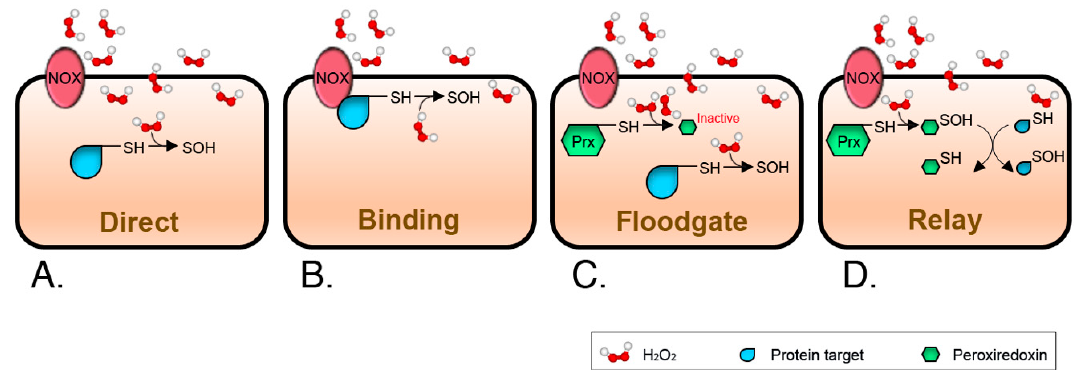
Figure 2. Main models for ROS signal transmission to specific cysteines. ( A ) The direct model presumes that redox targets (depicted as a blue teardrop) are constituted by proteins whose rate constant of oxidation is higher than that of the reaction of ROS with its major cellular scavengers, particularly peroxiredoxins. Direct chemical reaction of ROS with those targets is thus kinetically possible and leads to their oxidation. ( B ) The binding hypothesis proposes that H 2 O 2 sources and targets are bound or in close proximity, allowing for site-localized oxidation to occur. Also in this case, ROS will directly oxidize targets but as a function of their relative proximity to the source instead of depending on their rate constant of reaction. ( C ) The floodgate model overcomes the apparent kinetic limitation of target oxidation by suggesting that overoxidation of peroxiredoxins (represented by green hexagons) permits further oxidation of other proteins with slower reaction rates. ( D ) Peroxiredoxins have been already shown to behave as relays, transmitting redox equivalents to targets during their oxidation–reduction cycle, and thus allowing for signal transduction. This model implies an indirect ROS effect on targets, as ROS will oxidize peroxiredoxins and will not chemically react with targets. In all cases, a plasma-membrane-bound NADPH oxidase (NOX, in dark pink) has been chosen as a representative source of ROS acting at the cellular surface. Note that the four possibilities are not mutually excluding.